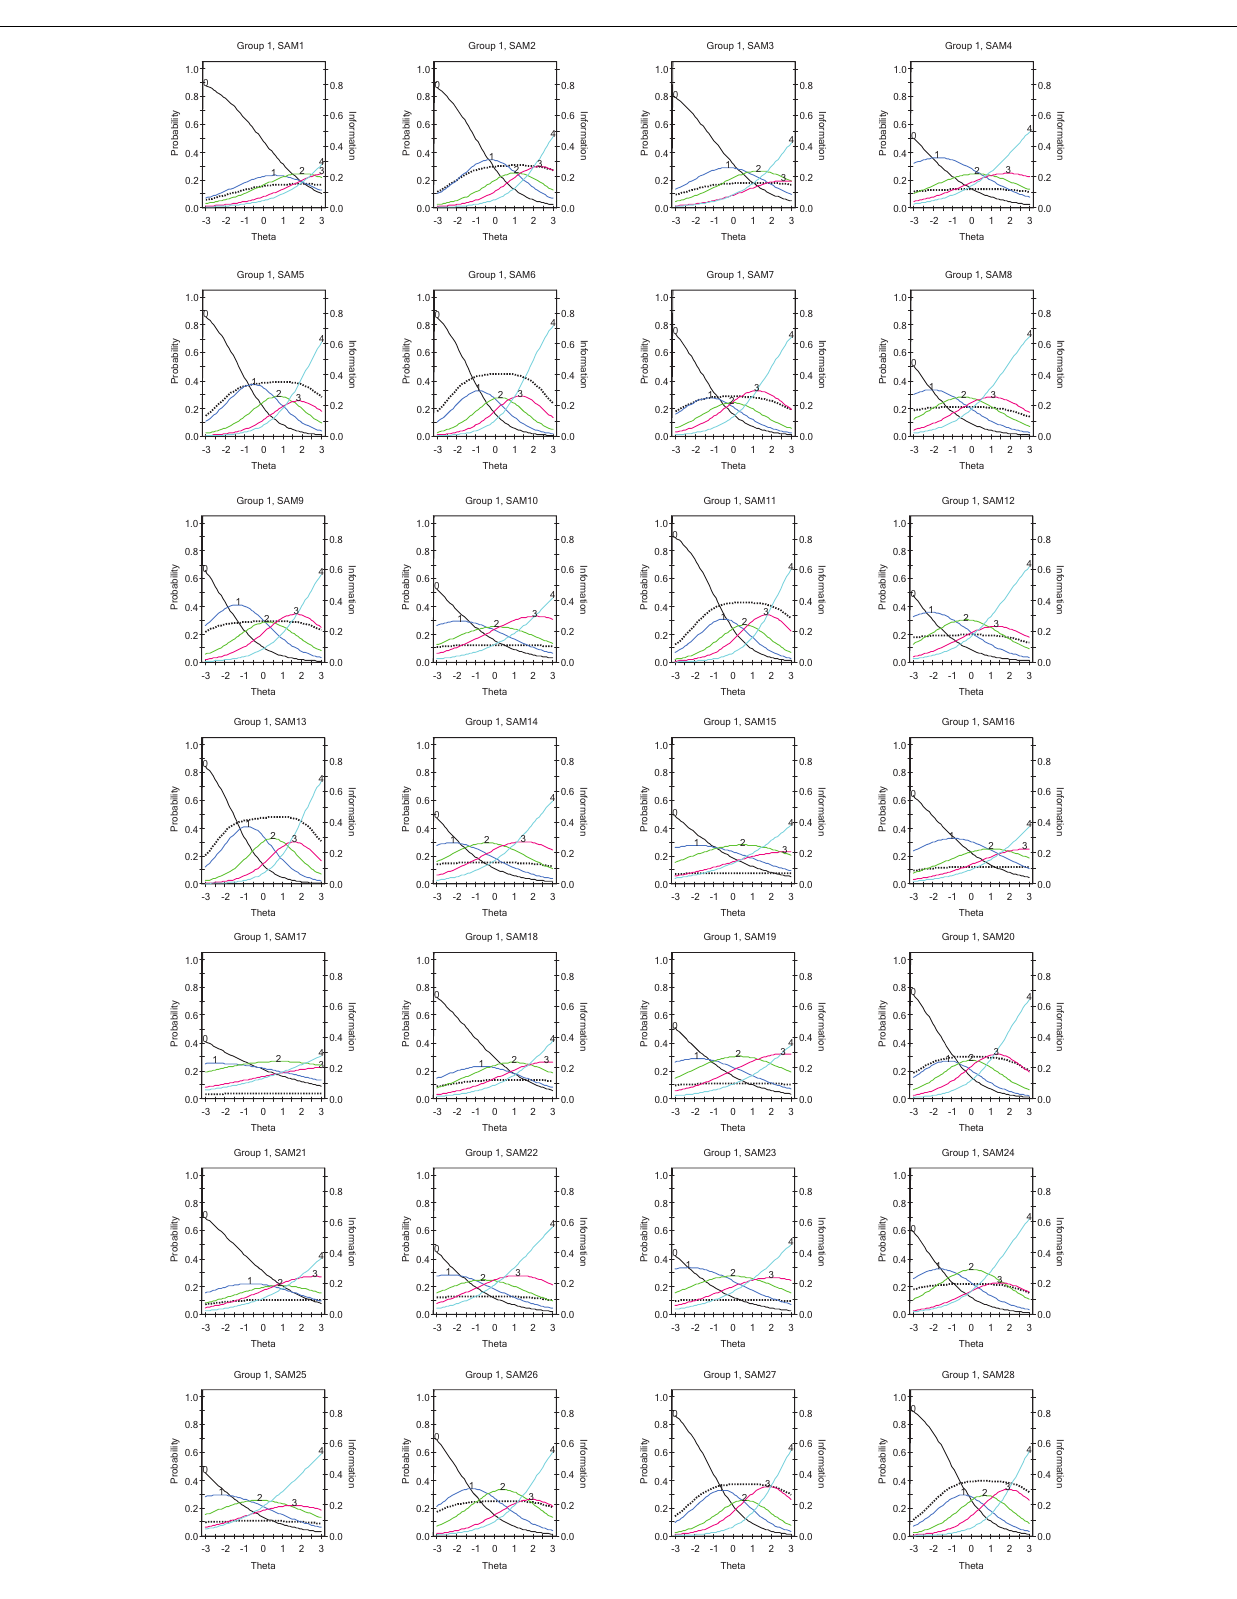
FIGURE 2 | Item characteristics and information